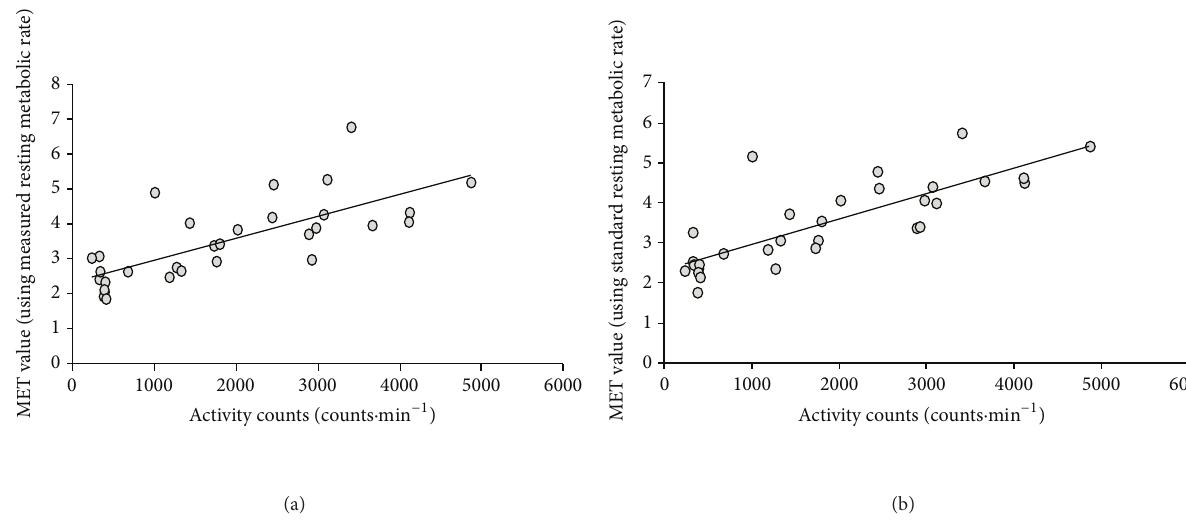
Figure 3: (a) Relationship between MET values and activity counts for elderly group using measured metabolic rate ( 𝑅 2 = 0.57 , standard error of estimate = 0.83 ). (b) Relationship between MET values and activity counts for elderly group using standard (3.5 mL ⋅ kg ⋅ min −1 ) metabolic rate ( 𝑅 2 = 0.52 , standard error of estimate = 0.85